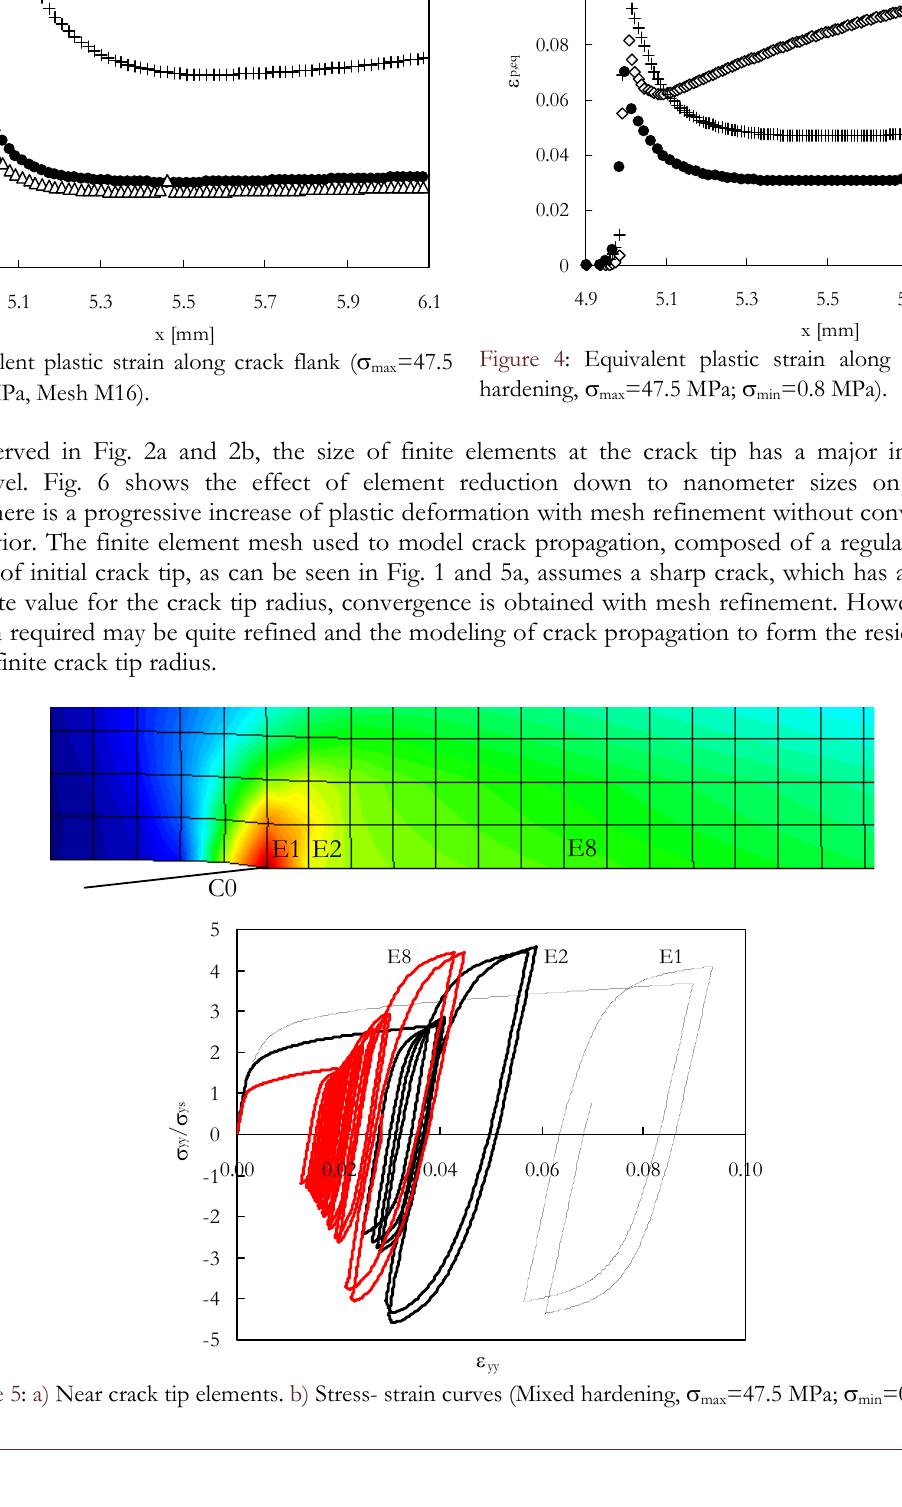
Figure 5: a) Near crack tip elements. b) Stress- strain curves (Mixed hardening,  max =47.5 MPa;  min =0.8